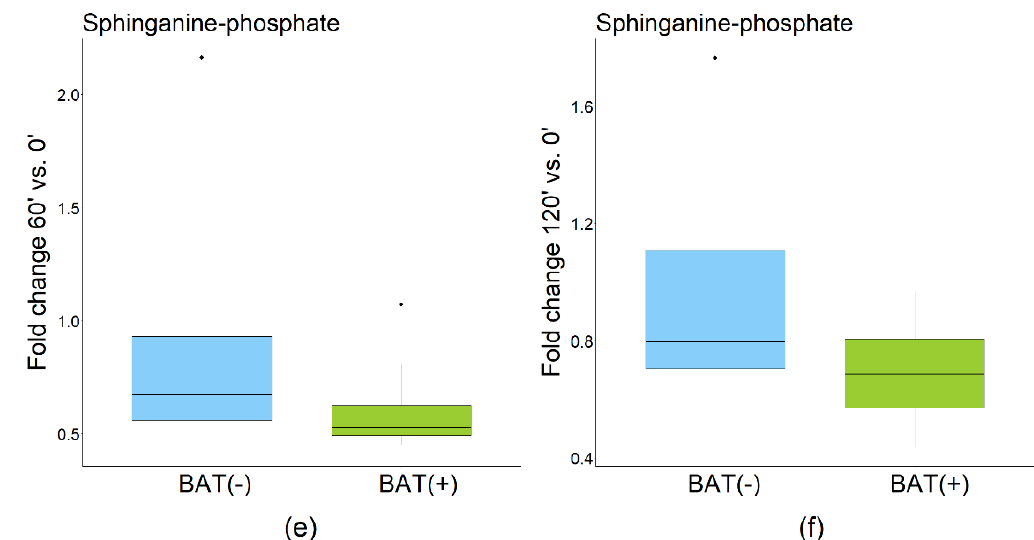
Figure 3. Fold change (FC) of most significant metabolites in BAT(+) and BAT( − ) group. ( a ) Fold change of LPE(20:4) after 60 min of CE; ( b ) Fold change of LPE(20:4) after 120 min of CE; ( c ) Fold change of DHA after 60 min of CE; ( d ) Fold change of DHA after 120 min of CE; ( e ) Fold change of sphinganine-phosphate after 60 min of CE; ( f ) Fold change of sphinganine-phosphate after 120 min of CE. The dots indicate outliers.